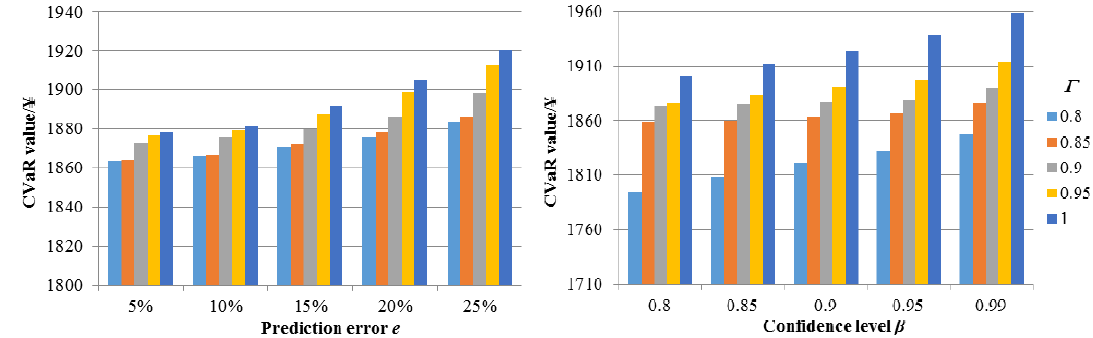
Figure 11. The CVaR values of VPP operation under different β , Γ and e (typical winter